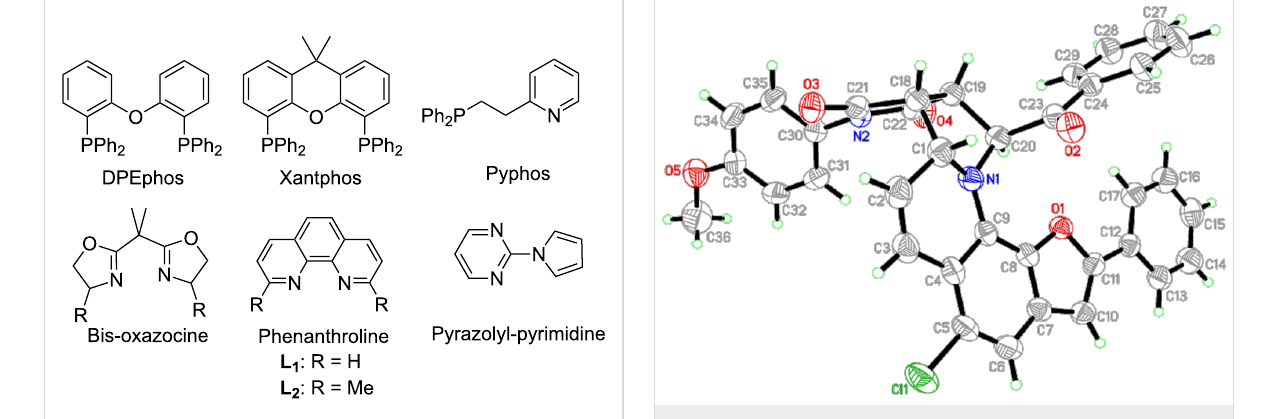
(55–58% yield; Table 1, entries 21–25) than bi-/tridentate ligands (65–94% yield; Table 1, entries 26–32), and phos-